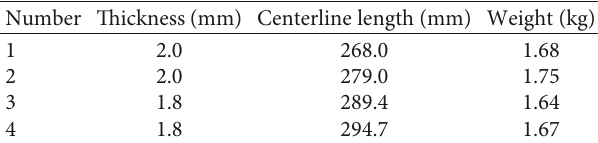
Table 7: Centerline and weight of the